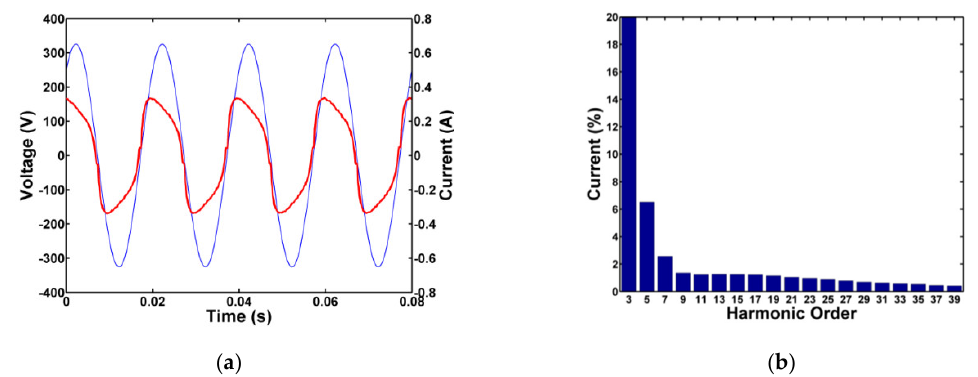
Figure 6. Waveforms of instantaneous values of current and voltage ( a ) for luminaire marked as LUM4 and ( b ) current harmonic spectrum.